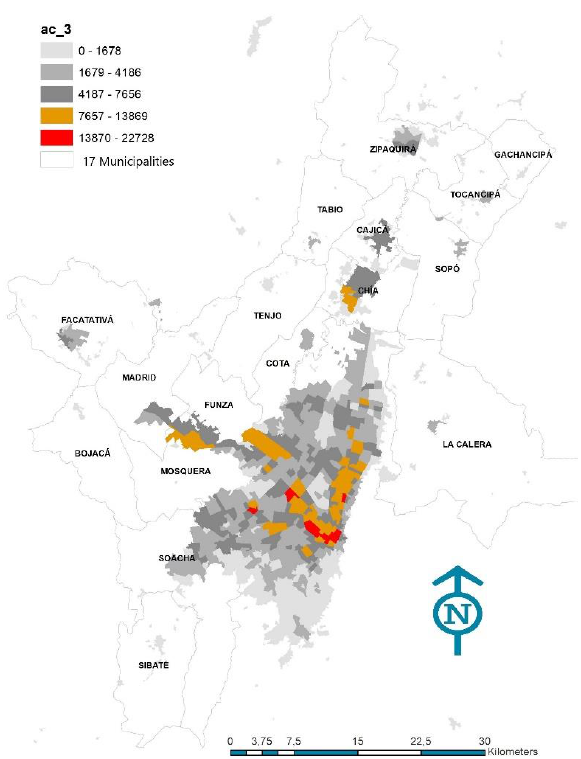
Figure 3. Accessibility indicator with friction parameter equal to 3. Based on information from the EEEBR (2017).